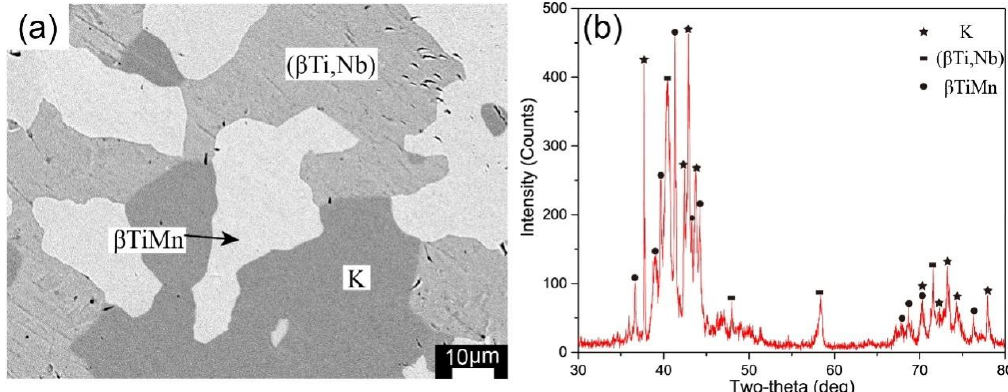
Figure 24. Alloy C5 annealed at 1373K for 40 days: ( a ) BSE images, ( b ) XRD patterns.